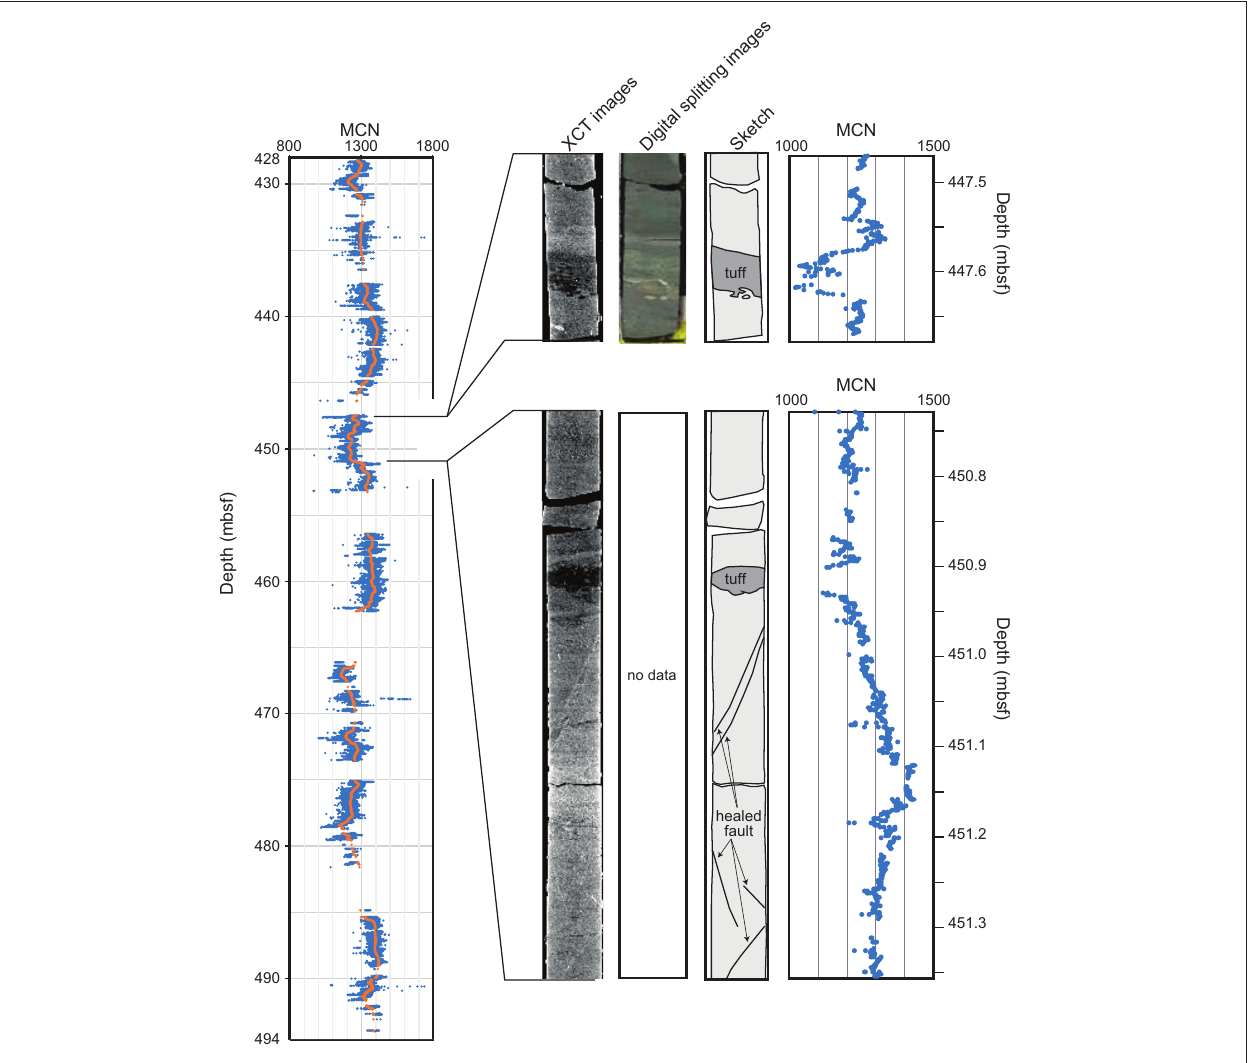
FIGURE 6 | Downhole quality-controlled MCN profile of the trench-to-basin facies (428.0–494.0 mbsf). Orange plots are 500-slices moving averages of MCN. XCT images, digital splitting images, sketches and close up MCN profiles around typical negative (core C0023A-20R-1, 48–67 cm) and positive spikes (from core C0023A-20R-3, 116 cm to core C0023A-20R-4, 52 cm) of the facies are shown.